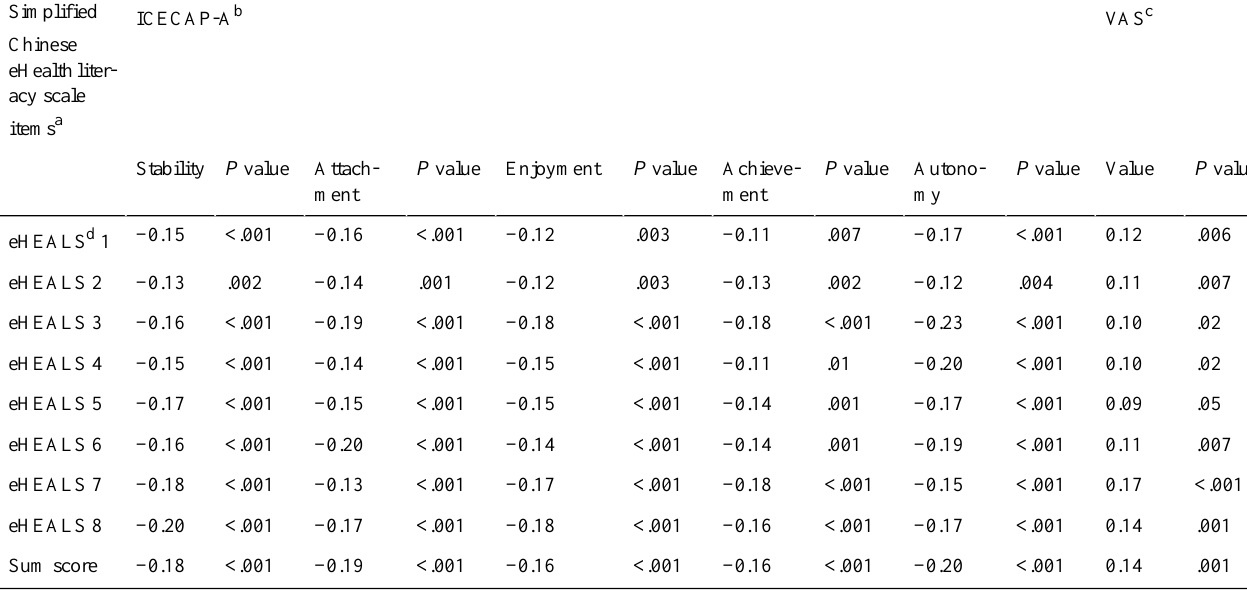
Table 3. Convergent validity of the simplified Chinese eHealth literacy scale.